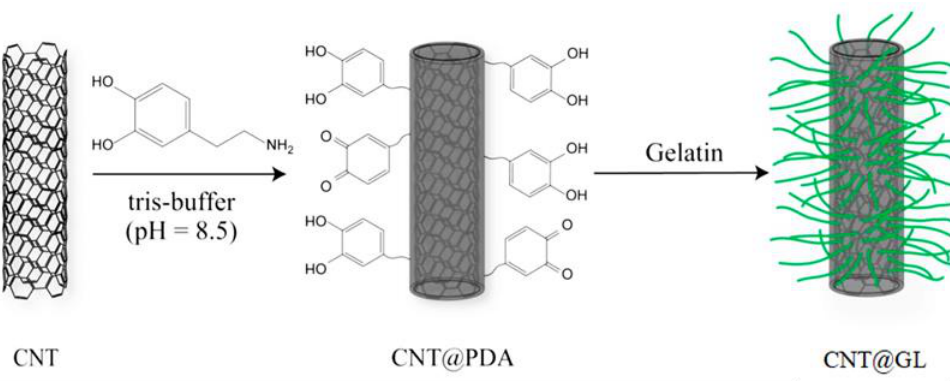
Figure 2. Illusion of the surface modification of CNT with GL [77].